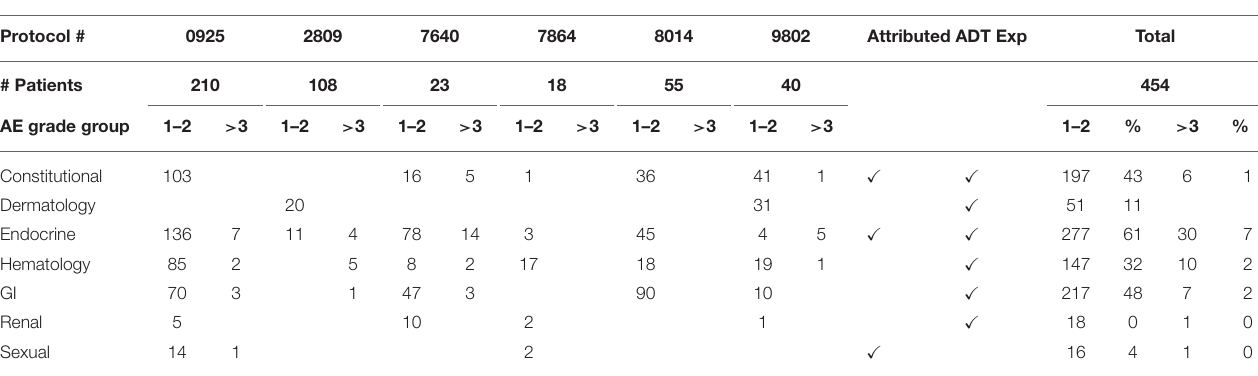
TABLE 3 | Adverse